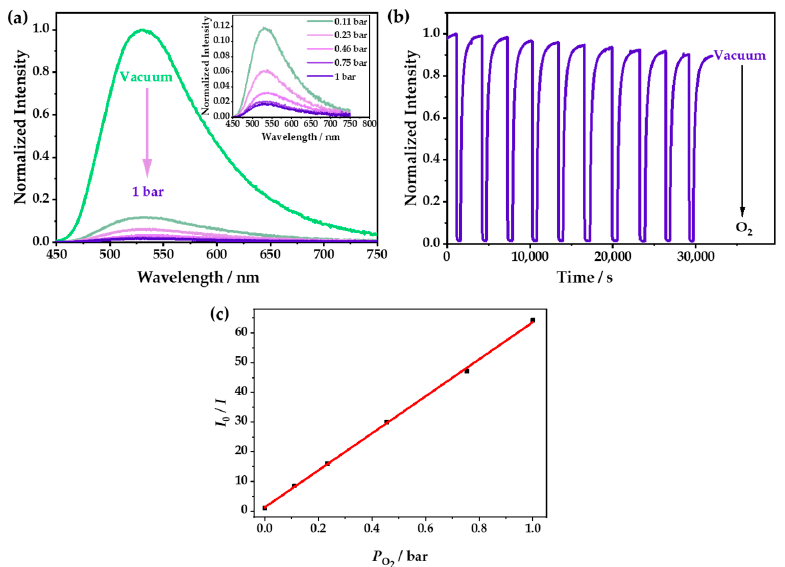
Figure 4. ( a ) The emission spectra of 1 at different O 2 pressures under an excitation of 365 nm. ( b ) The time-dependent spectrum of 1 when switching between a vacuum and 1 bar O 2 —excited at 365 nm and detected at 542 nm. ( c ) The Stern–Volmer plots of 1 at different O 2 pressures—excited at 365 nm and detected at 542 nm.